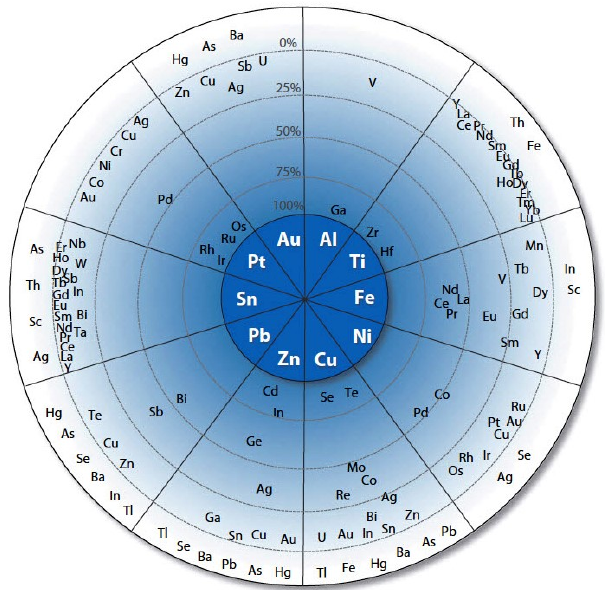
Figure 1. The wheel of metal companionability [2].